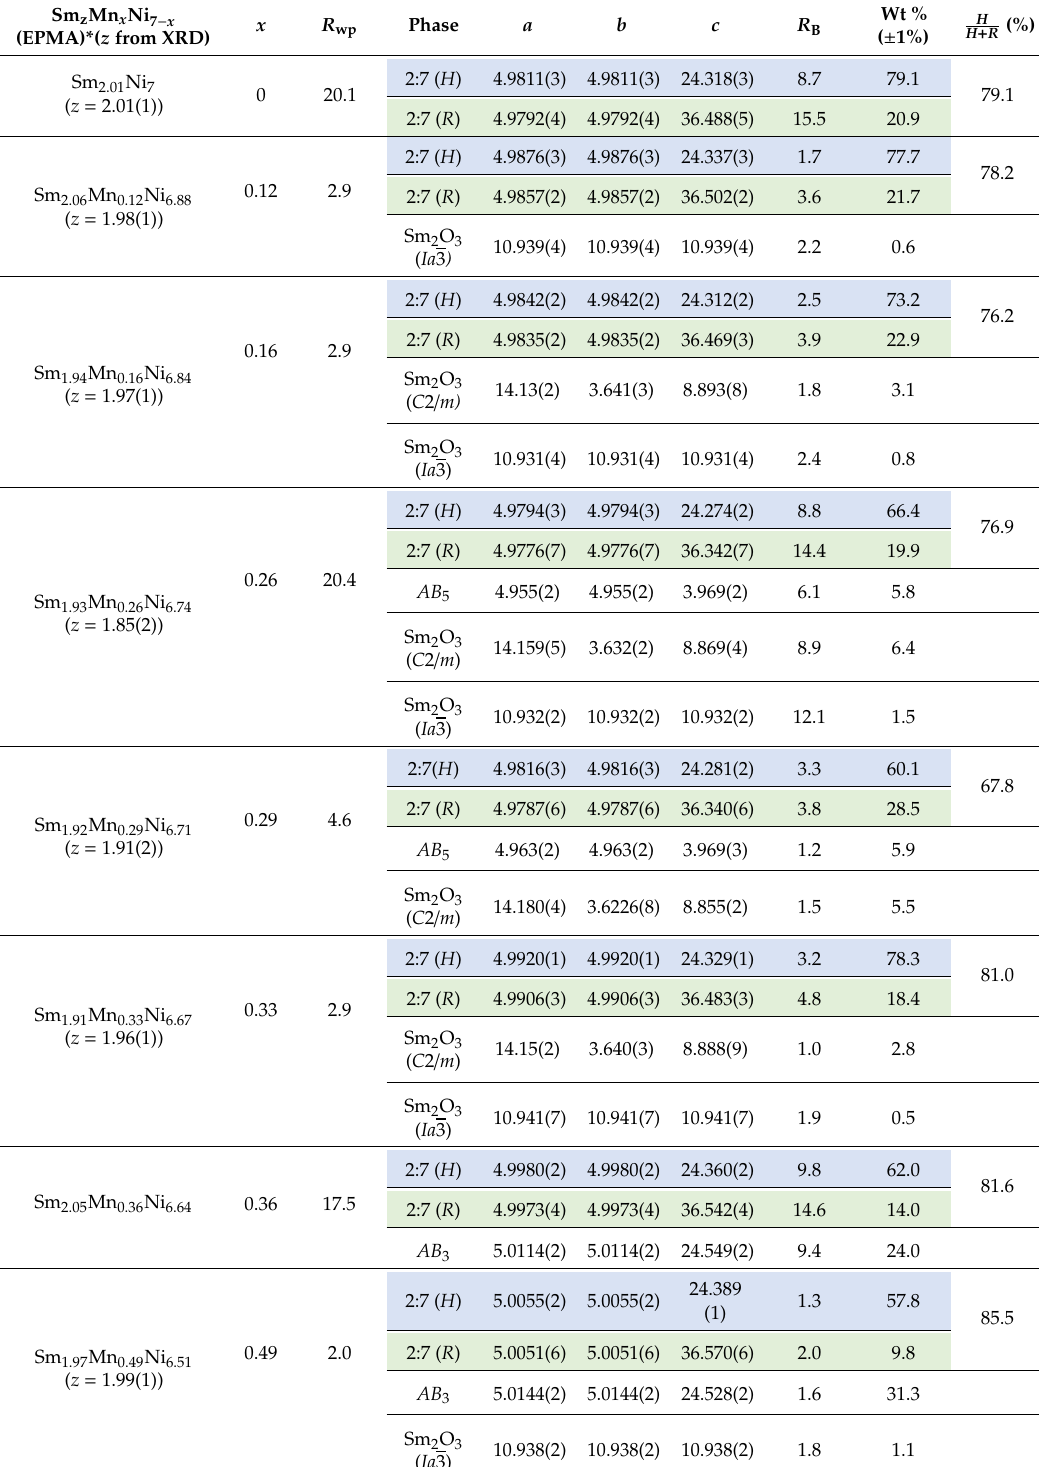
Table 1. Results of Electron Probe Micro-Analysis (EPMA) and XRD characterizations of Sm 2 Mn x Ni 7 − x (0 ≤ x ≤ 0.49). All atomic positions were fixed to those published for Sm 2 Ni 7 [25]. Sm z Mn x Ni 7 − x (EPMA)*( z from